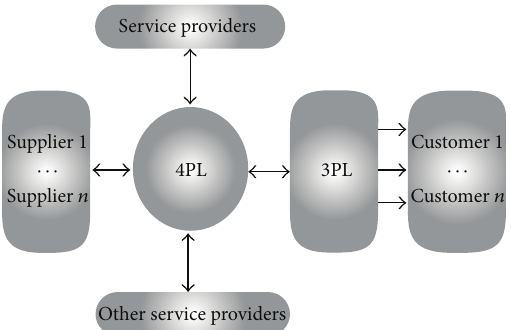
Figure 1: The fourth party logistics supply chain